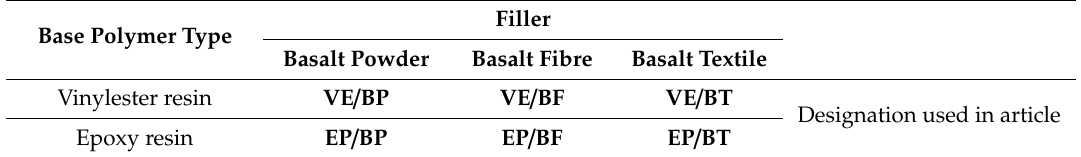
Table 2. Designations of composite samples used in Results and Discussion section.